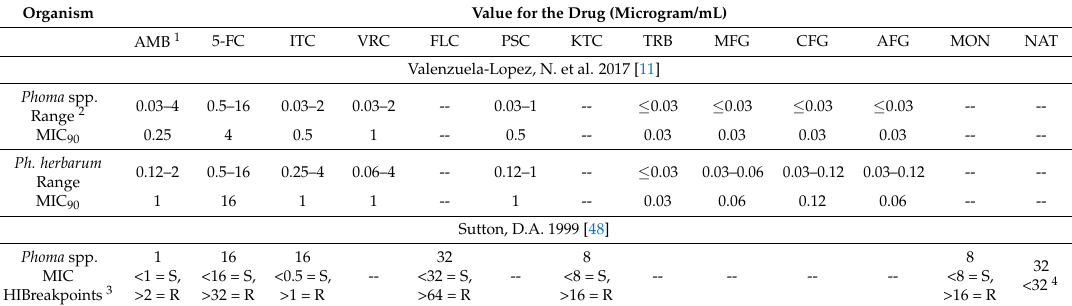
Table 2. Results of in vitro Susceptibilities of Systemic Antifungals to Phoma spp.